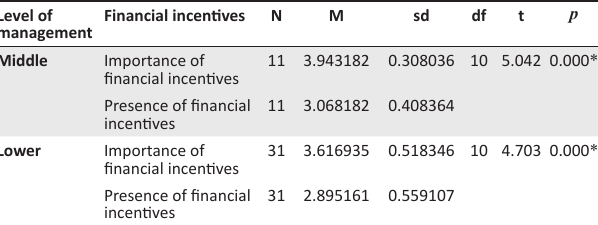
TABLE 2: Testing the difference between the presence and the importance of financial incentives.